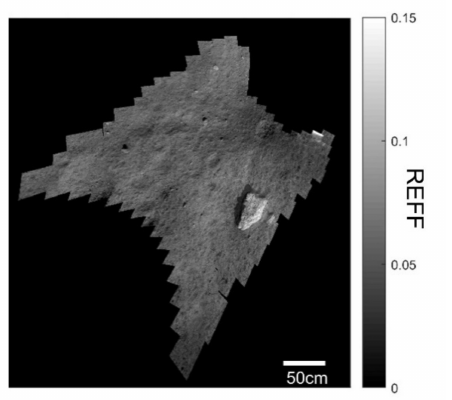
Figure 7. REFF image from the LMS at 900 nm using the full-view